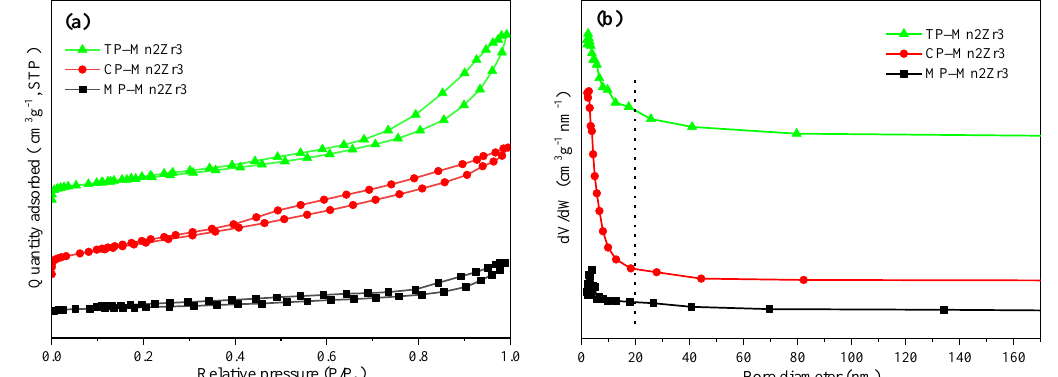
Table 2. The surface area, average pore diameter, and pore volume of TP-Mn2Zr3, CP-Mn2Zr3, and MP-Mn2Zr3 catalysts.